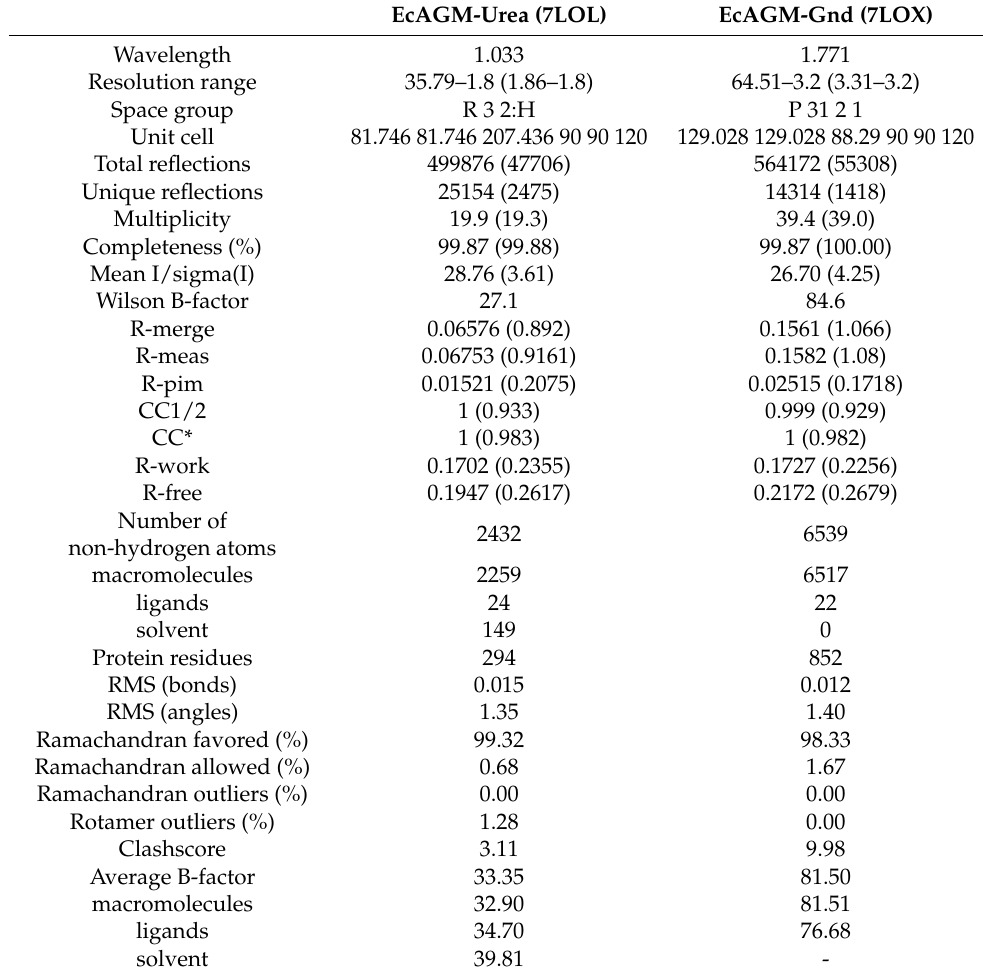
Table 2. Data collection and refinement statistics of crystal